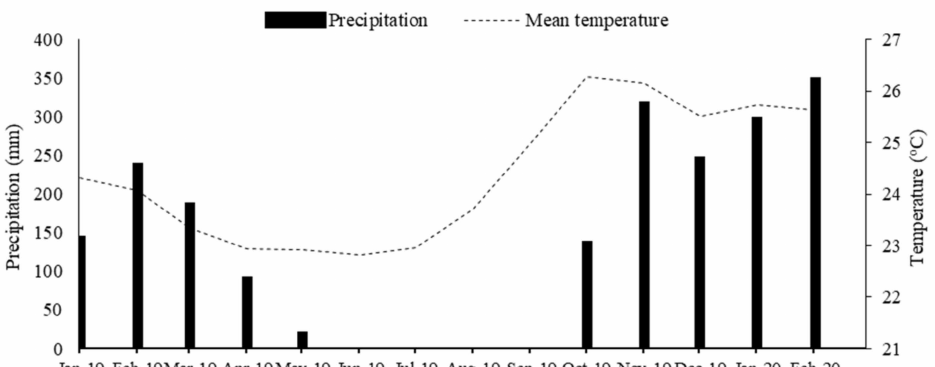
Figure 1. Average air temperature and precipitation values during the experimental period. Rio Verde, Goias, 2019/2020. Source: National Institute of Meteorology (INMET)—Climatological Station of the University of Rio